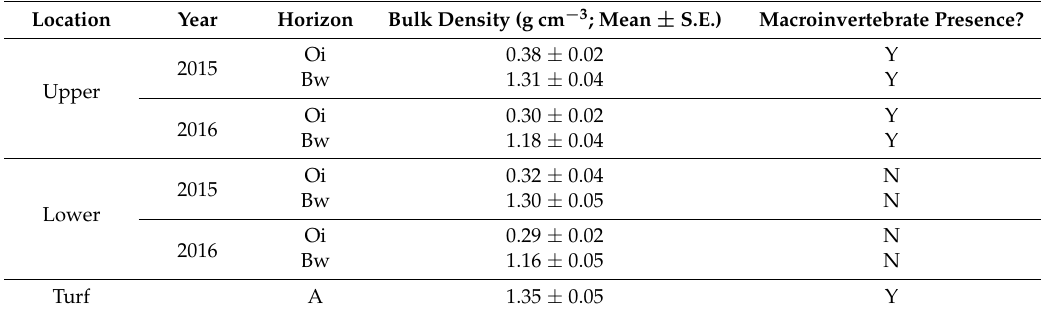
Table 4. Bulk density for different soil horizons in rain garden and turf areas, and a qualitative observation of macroinvertebrate